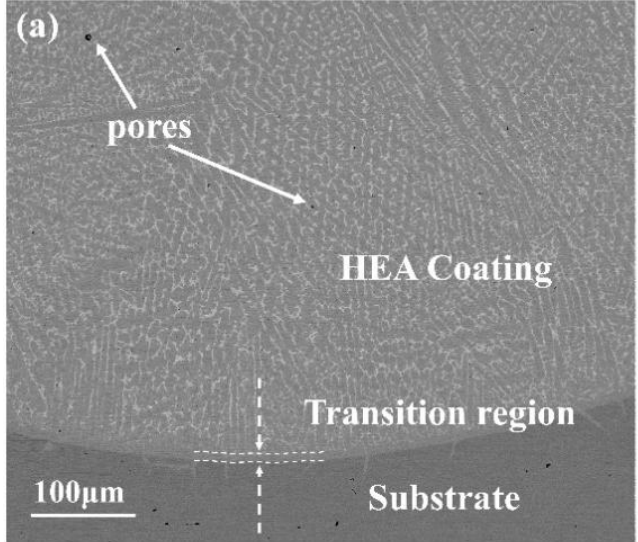
( a ) Figure 7. Cont